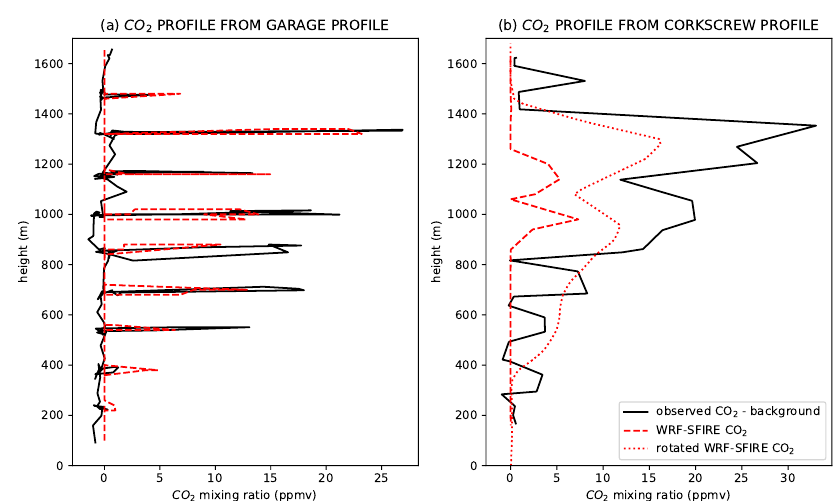
Figure 5. Observed (black) and modeled (red) vertical CO 2 emissions distribution during: ( a ) “parking garage” maneuver; and ( b ) corkscrew